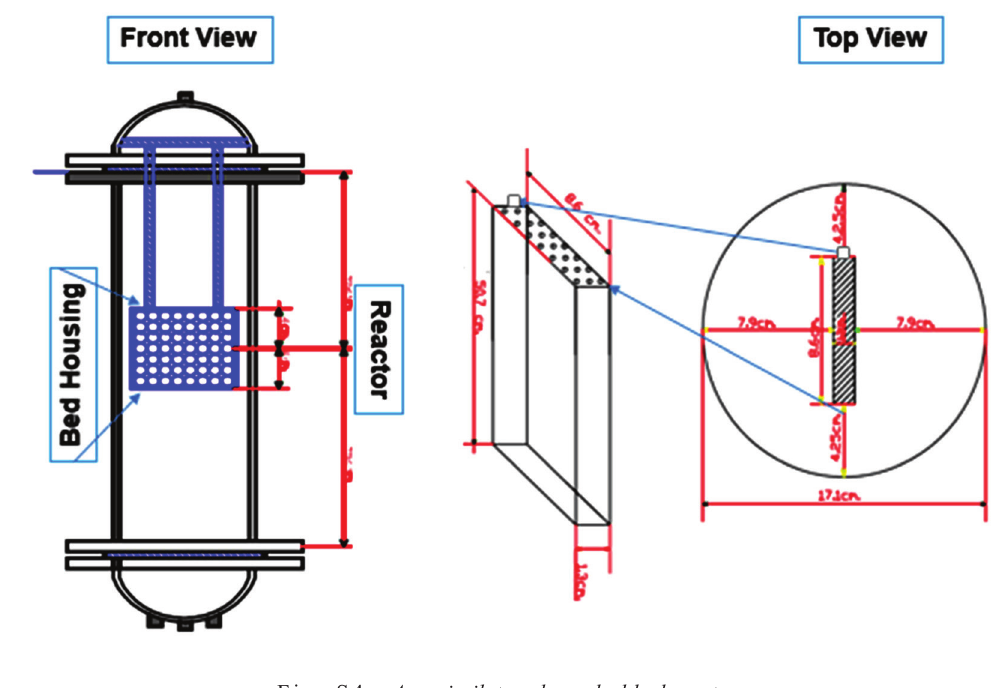
Fig. S4 – A semi-pilot-scale packed bed